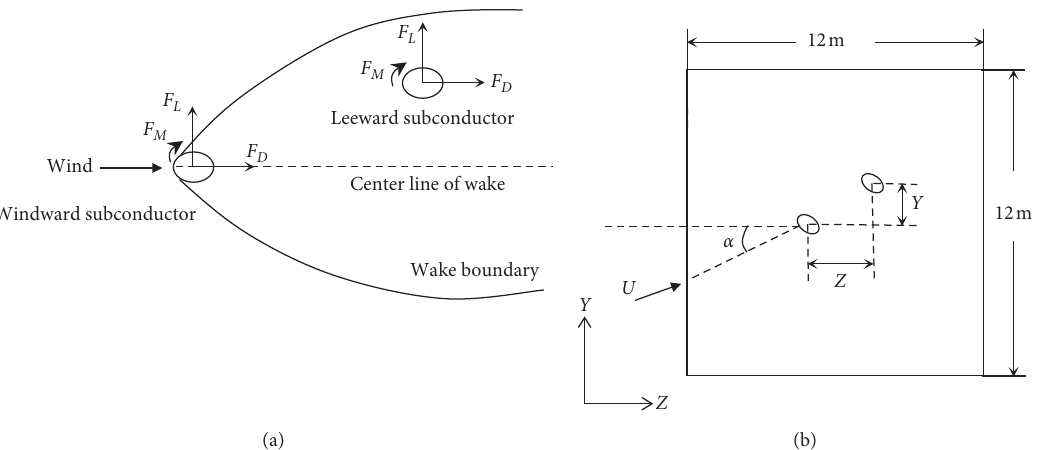
Figure 4: The influence region of iced twin bundle conductors and the numerical model: (a) wake influence zone and (b) a numerical model for the relative position between two